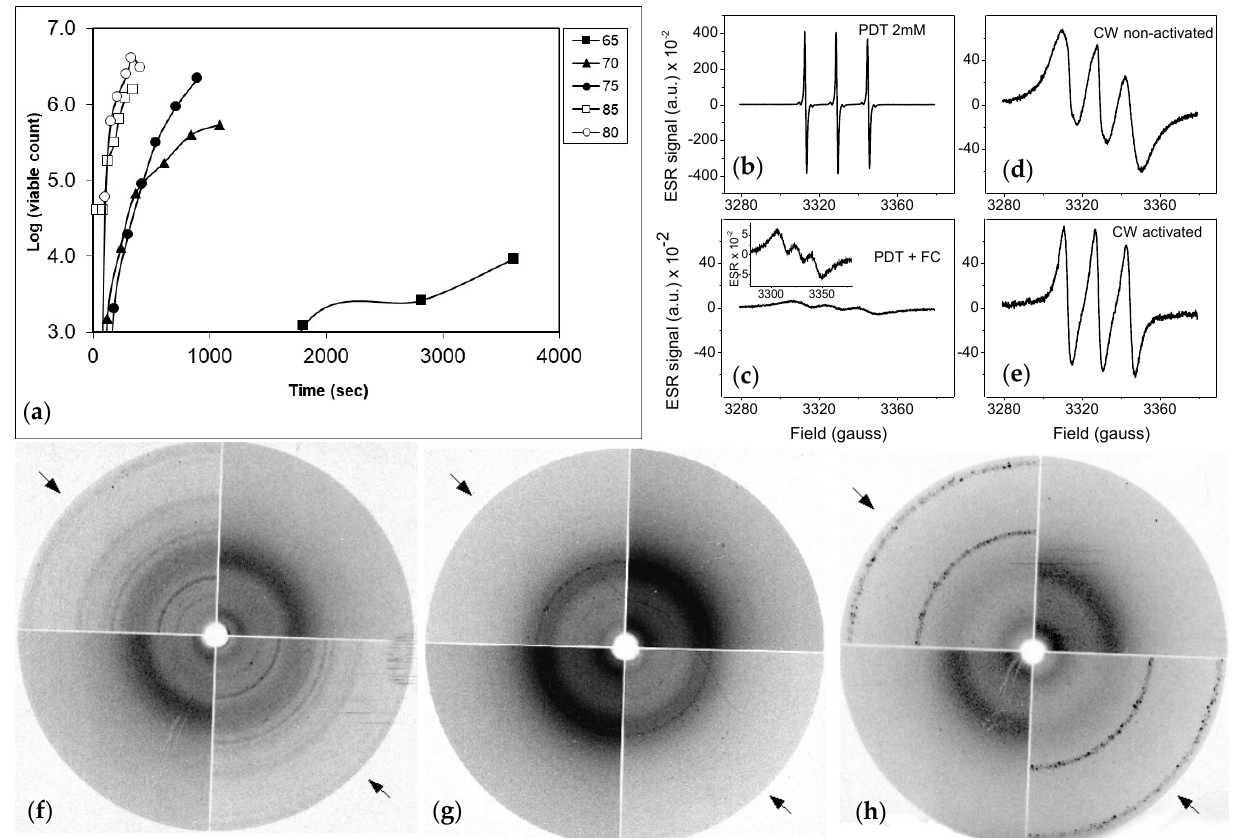
Figure 1. Cell walls of ascospores of T. macrosporus change in structure after heat activation. ( a ) Heat-activation of ascospores is only observed at temperatures above 70 ◦ C and increase in speed at higher temperatures; ( b , c ) ESR spectra of PDT plus FC added. Note that the scale of PDT signal in liquid is large ( b ), while it is very reduced in the presence of FC ( c ). The inset shows the shape of the signal including three peaks; ( d , e ) Spectra of cell walls from dormant and activated spores. The signal of PDT of activated cell walls has more narrow lines, indicating that a structural change has taken place during activation. ( f – h ) X-ray diffraction patterns of broken, freeze dried cell walls. ( f ) shows diffraction patterns of broken cell walls of ascospores, ( g ) shows diffraction patterns of broken cell walls after they have been treated with 2% SDS at 100 ◦ C for ten minutes. ( h ) shows the diffraction patterns of spores that have had the same SDS treatment in ( g ) but with an additional treatment with 1 N KOH of 20 min at 60 ◦ C. Arrows indicate two diffraction patterns of activated spores; the other two quarters of the circles represent diffraction patterns of non-activated spores.